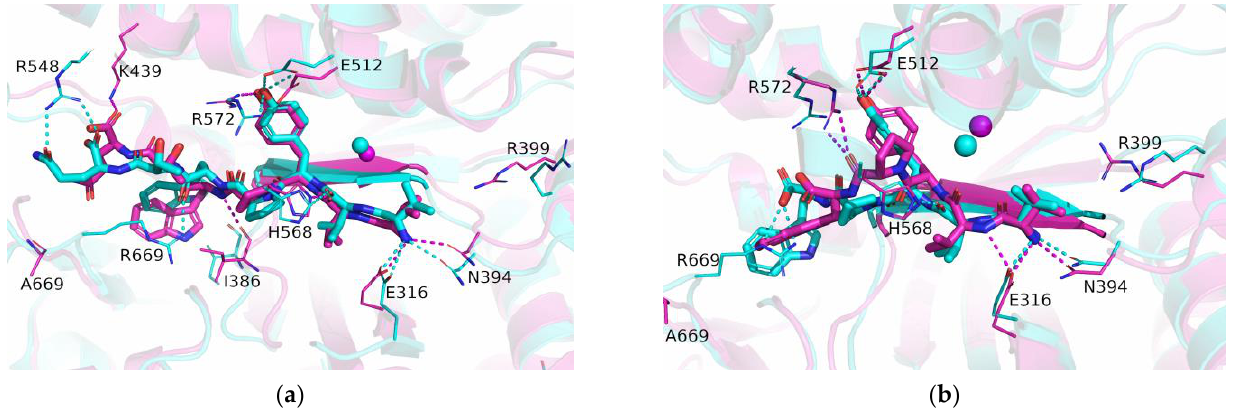
Figure 4. Binding of valorphin ( a ) and tynorphin ( b ) with the wild-type (cyan) and the R669A mutated (magenta) DPP III enzymes. Shown are optimized structures obtained after 1 µs of MD simulations. The amino acid residues that formed hydrogen bonds (indicated by dashed lines) with the ligand are shown as thin sticks, as are the amino acid residues that formed polar interactions with the ligand. Mutated residues are also shown as thin sticks. The β -sheet (residues A388-N391) from the lower protein domain involved in antiparallel binding of the ligand is shown as an opaque cartoon. The zinc ion is shown as a sphere. The hydrogen atoms are not shown, nor are the main chain atoms, except at A699.